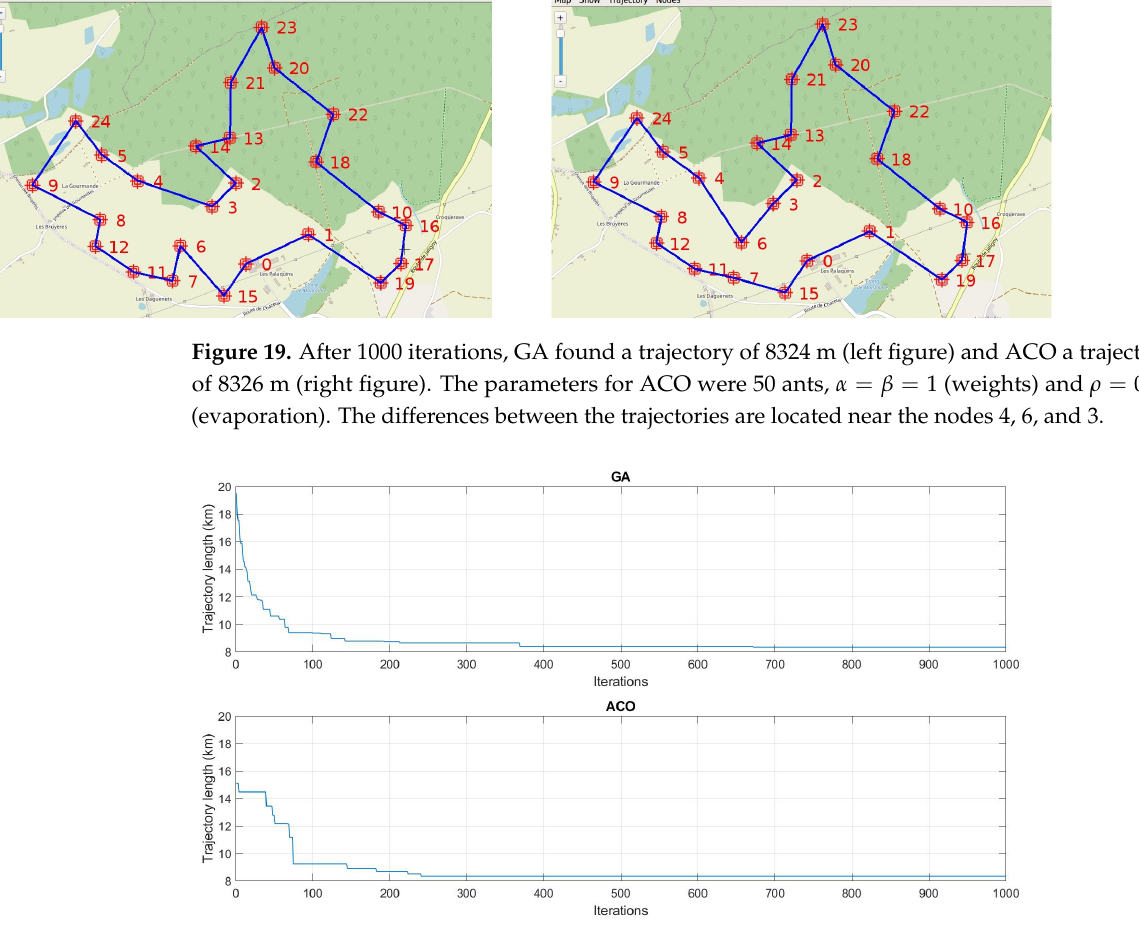
Figure 20. Evolution of the GA and ACO algorithms. GA converges from 19,537 m (first iteration) to 8324 m. ACO converges from 15,106 m (first iteration) to 8326